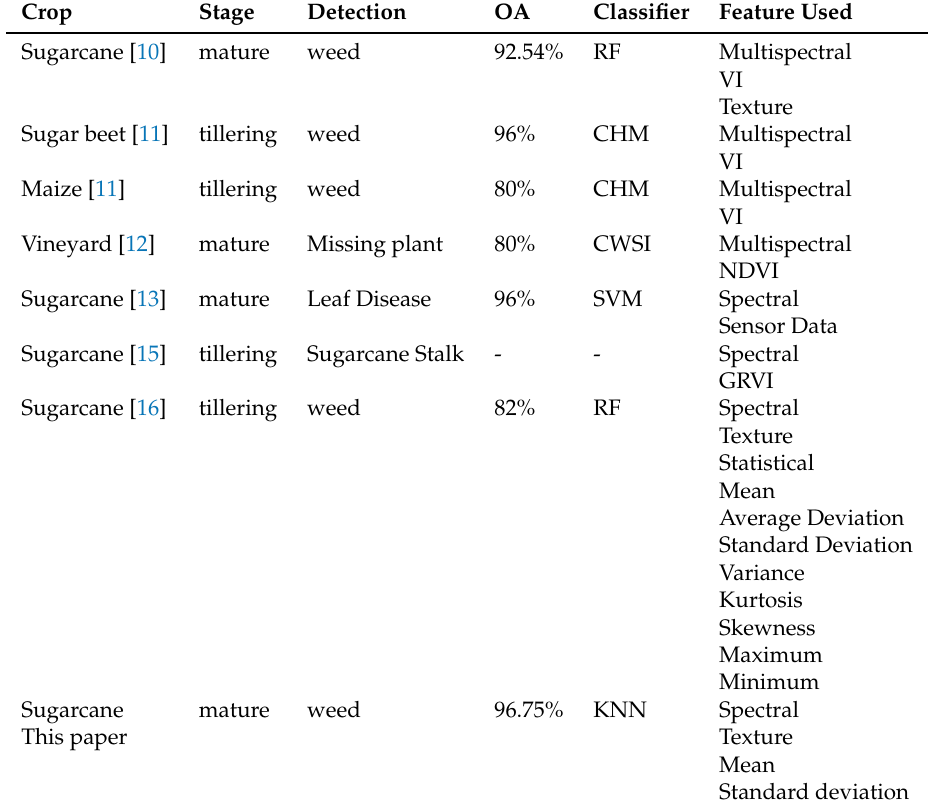
Table 7. Comparison of weed detection applications considering factors such as overall accuracy (OA), classifier, and types of features